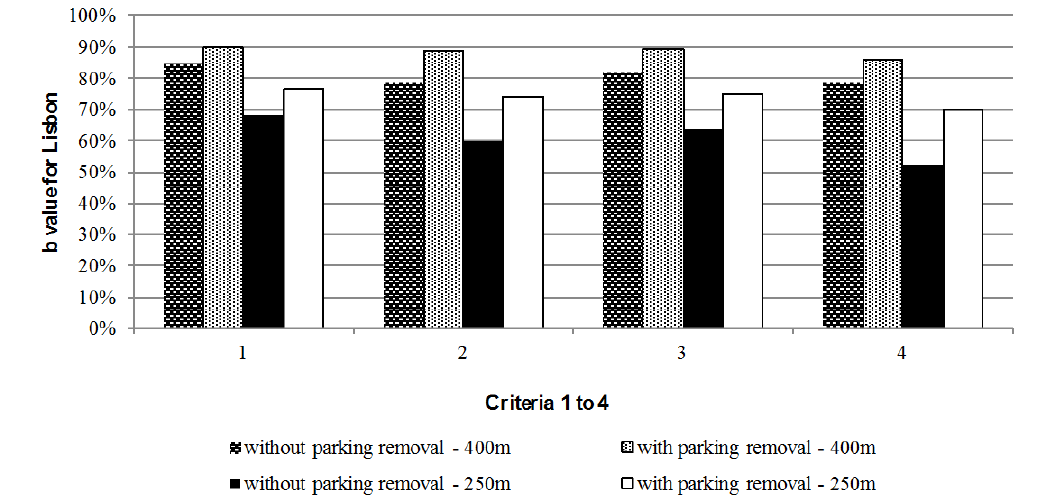
Figure 10. β values calculated for the municipality of Lisbon for 250m and 400m mesh widths Fig.9 illustrates also the TAZ – thinner black lines – and identifies the TAZ that